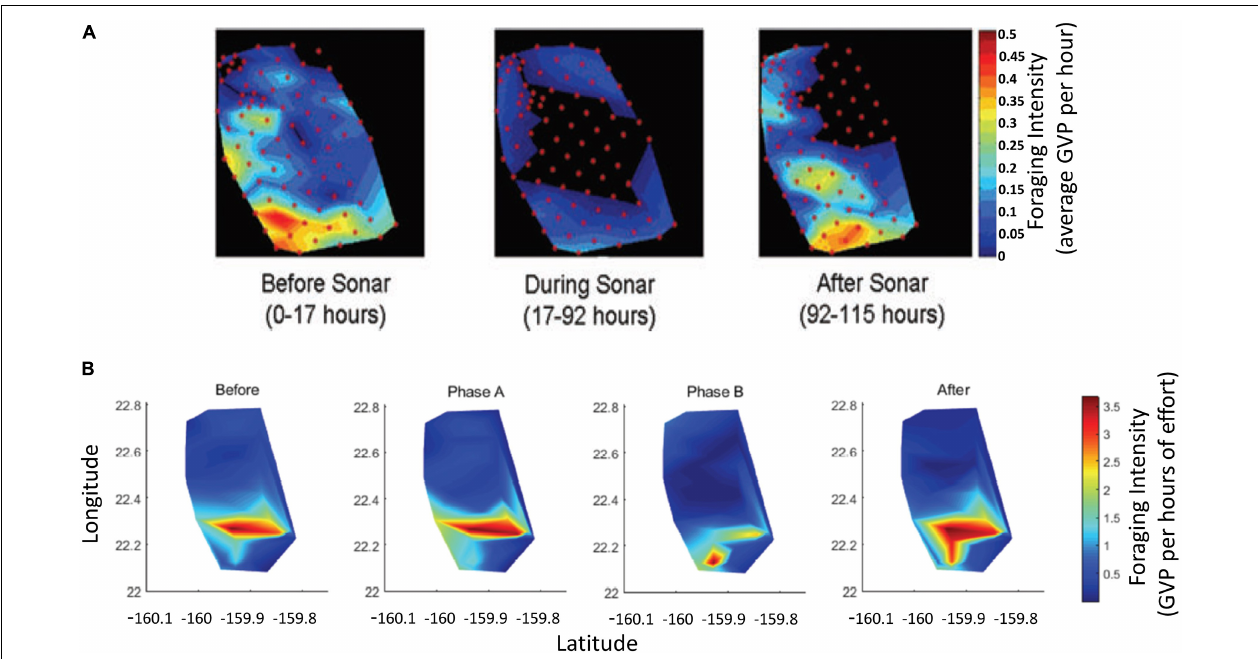
FIGURE 5 | (A) Reproduced from Figure 6 in McCarthy et al., 2011, which shows the foraging intensity, as the average GVP per hour, of Blainville’s beaked whales on the AUTEC hydrophone array Before, During, and After MFAS activity. Red circles indicate positions of the hydrophones in the McCarthy et al., 2011 study. Colorbar values and label have been rewritten for legibility from original figure. (B) Reproduced from Figure 3 in Manzano-Roth et al., 2016, which shows the foraging intensity in GVP per hours of effort of Blainville’s beaked whales on the PMRF array Before, during Phase A, during Phase B, and After Naval sonar activity. Color bar label has been added and was not present in original